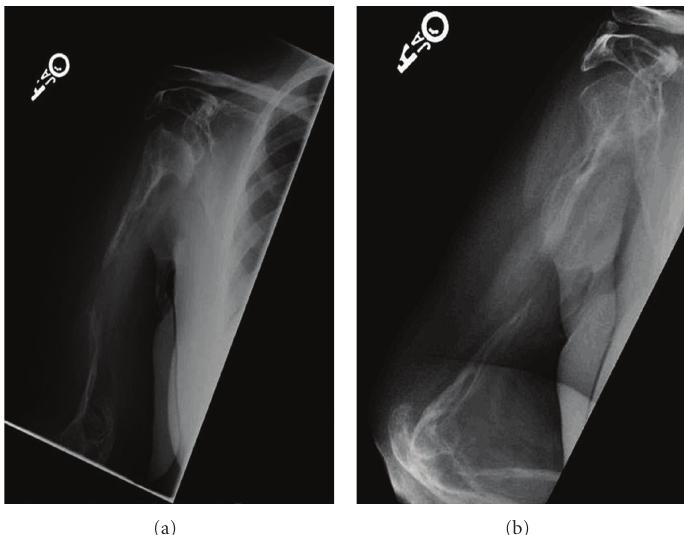
Figure 2: Anteroposterior and lateral plain radiographs of the humerus with di ff use osteopenia and extensive radiolucent foci in the intramedullary and subcortical regions of the bone, and disappearance of the midshaft humerus with tapering of the bone ends. Multiple lytic lesions of the scapula are also visible.